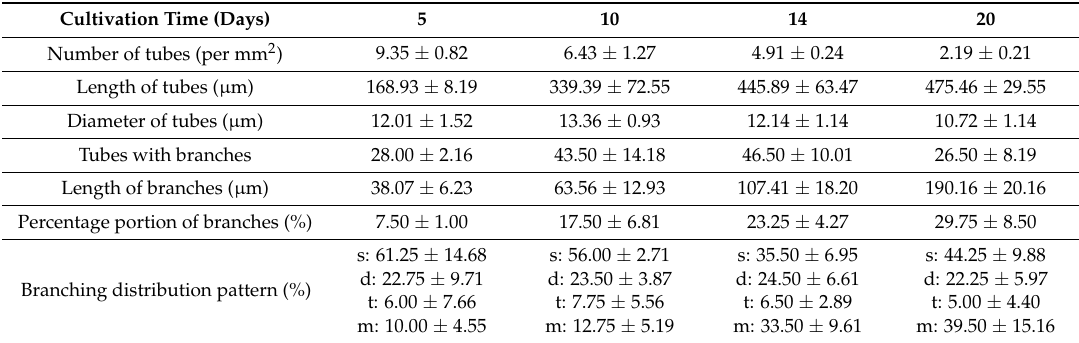
Table 1. Angiogenesis measurements. Data as mean ± standard deviations; s = single; d = double; t = triple; m =